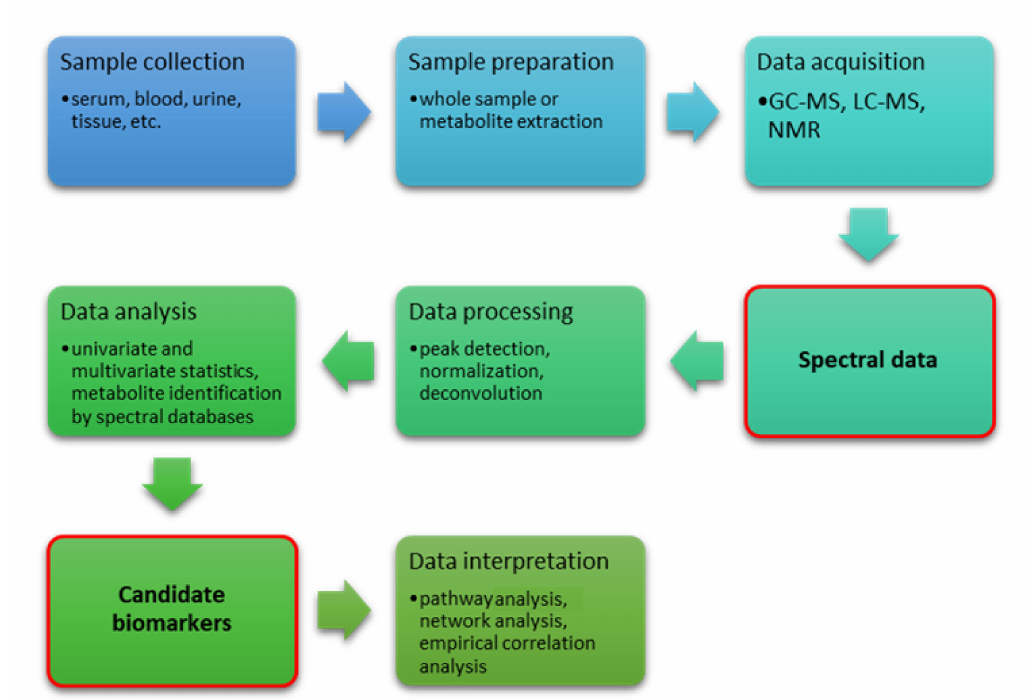
Figure 2. The workflow of metabolomics in sarcoma: both biofluids and tissue extract can be used as a whole or after metabolite extraction to reduce matrix complexity (steps 1–2); spectral data are first collected in a non-destructive way with samples by nuclear magnetic resonance followed by mass spectrometry, coupled either to gas chromatography or liquid chromatography (steps 3–4); both data from NMR and MS need extensive processing to resolve spectral overlapping and to quantify peak intensity, resulting in a table of calibrated peak intensities to be matched with metabolites with the aid of spectral databases (steps 5–6); univariate and multivariate statistics lead to candidate biomarkers being correlated with the pathologic state by pathway analysis and lab testing.